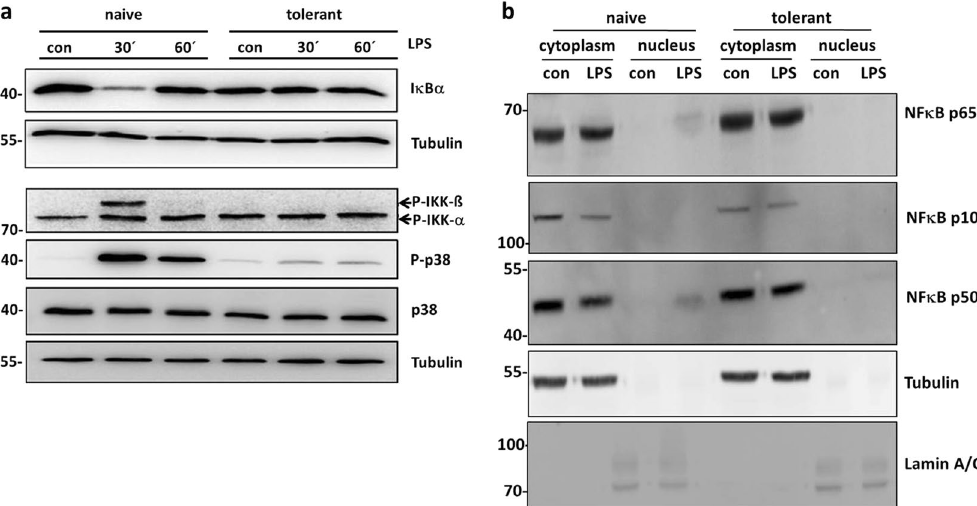
Figure 4. Impaired TLR4 signalling in tolerant BMMCs. Cells were preincubated with LPS (300 ng/ml) for 24 h to induce ET and stimulated with LPS (1 µ g/ml) for 30 min and 60 min. Subsequently, cells were lysed in the presence of phosphatase inhibitors. SDS-PAGE and Western blotting with antibodies specific for I κ B α , P-IKK- α /- β , P-p38, p38 and Tubulin (loading control) was performed ( a ). Because proteins of comparable size (p38 and I κ B α ) were analysed, the same lysates were separated on two gels with an anti-Tubulin loading control on each gel. Moreover, naive and tolerant cells were stimulated with LPS (2 µ g/ml) for 60 min and a cytosol/ nucleus fractionation was performed, followed by subsequent SDS-PAGE and Western blotting with antibodies specific for NF κ B p65, NF κ B p105 and p50 (both are detected by the same antibody), Tubulin, and Lamin A/C as loading controls ( b ). Western Blots are representative of two independent experiments with two biological